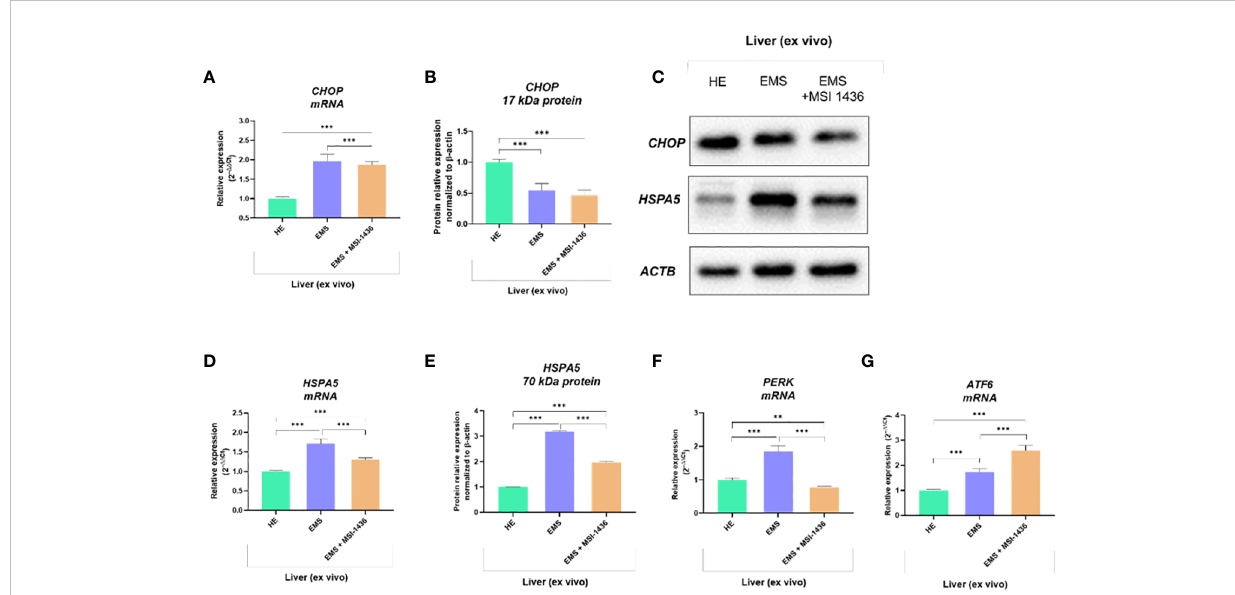
FIGURE 1 The expression pattern of ER stress-related biomarkers. The analysis included the determination of CHOP and HSPA5 expression at mRNA and protein levels (A-E) , and the determination of transcript levels for PERK (F) and ATF6 (G) . All results are shown as mean ± SD. Columns with bars represent means ± SD. **p-value < 0.001; ***p-value <